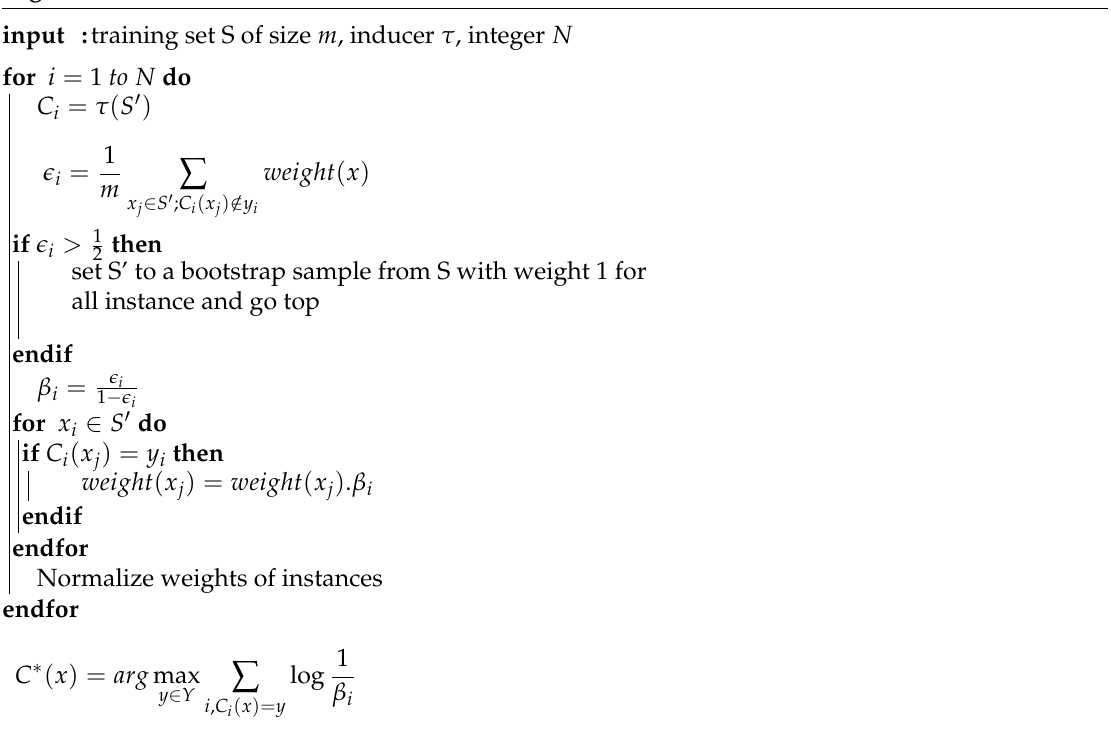
Algorithm 1 The AdaBoost